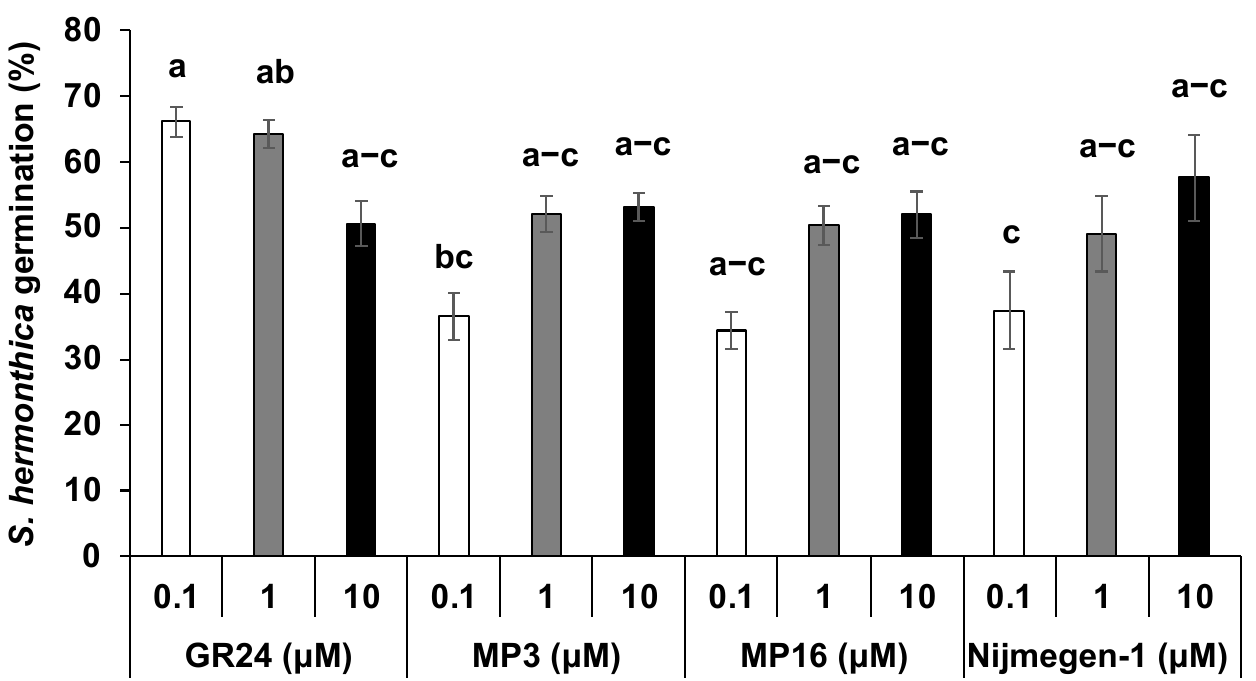
Figure 2. Striga seed germination rate in response to MP3, MP16, Nijmegen-1, and GR24. Various concentrations (10 − 5 –10 − 7 M) of selected SL analogs were applied to 10-day preconditioned Striga seeds. GR24 was used as a positive control and water as a negative control. For each SL analog, treatments with various letters differed significantly according to one-way analysis of variance (ANOVA) and Tukey’s post-hoc test ( p < 0.05). Error bars represent the standard error of the mean.